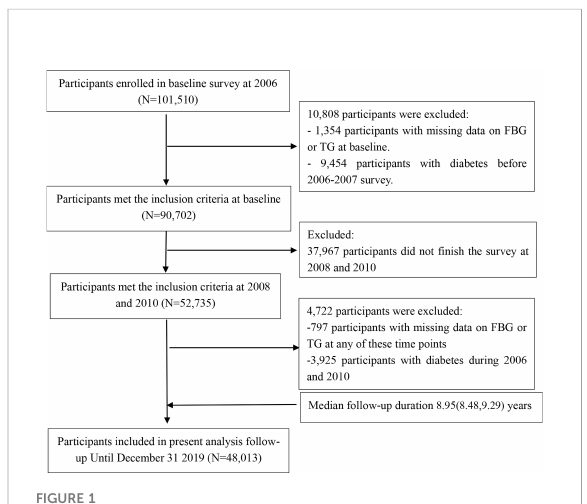
FIGURE 1 Flow chart for the inclusion of participants in the